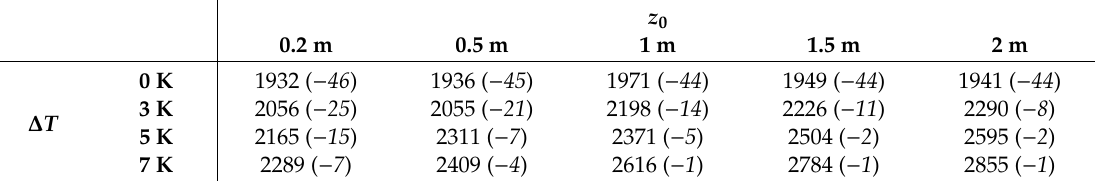
Table 2. Surface-based CAPE (J kg − 1 ) and CIN (J kg − 1 , italicized) over the idealized city at t = 120 min.